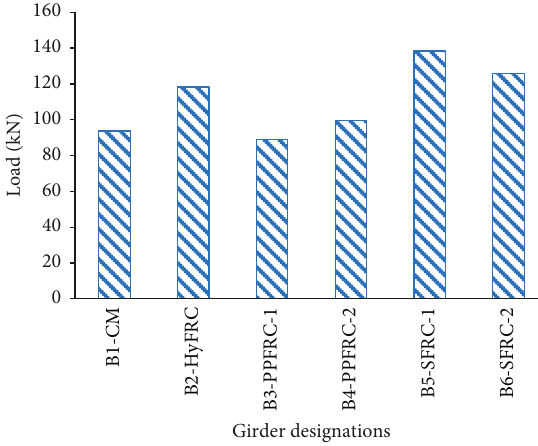
Figure 8: Load at the first crack.